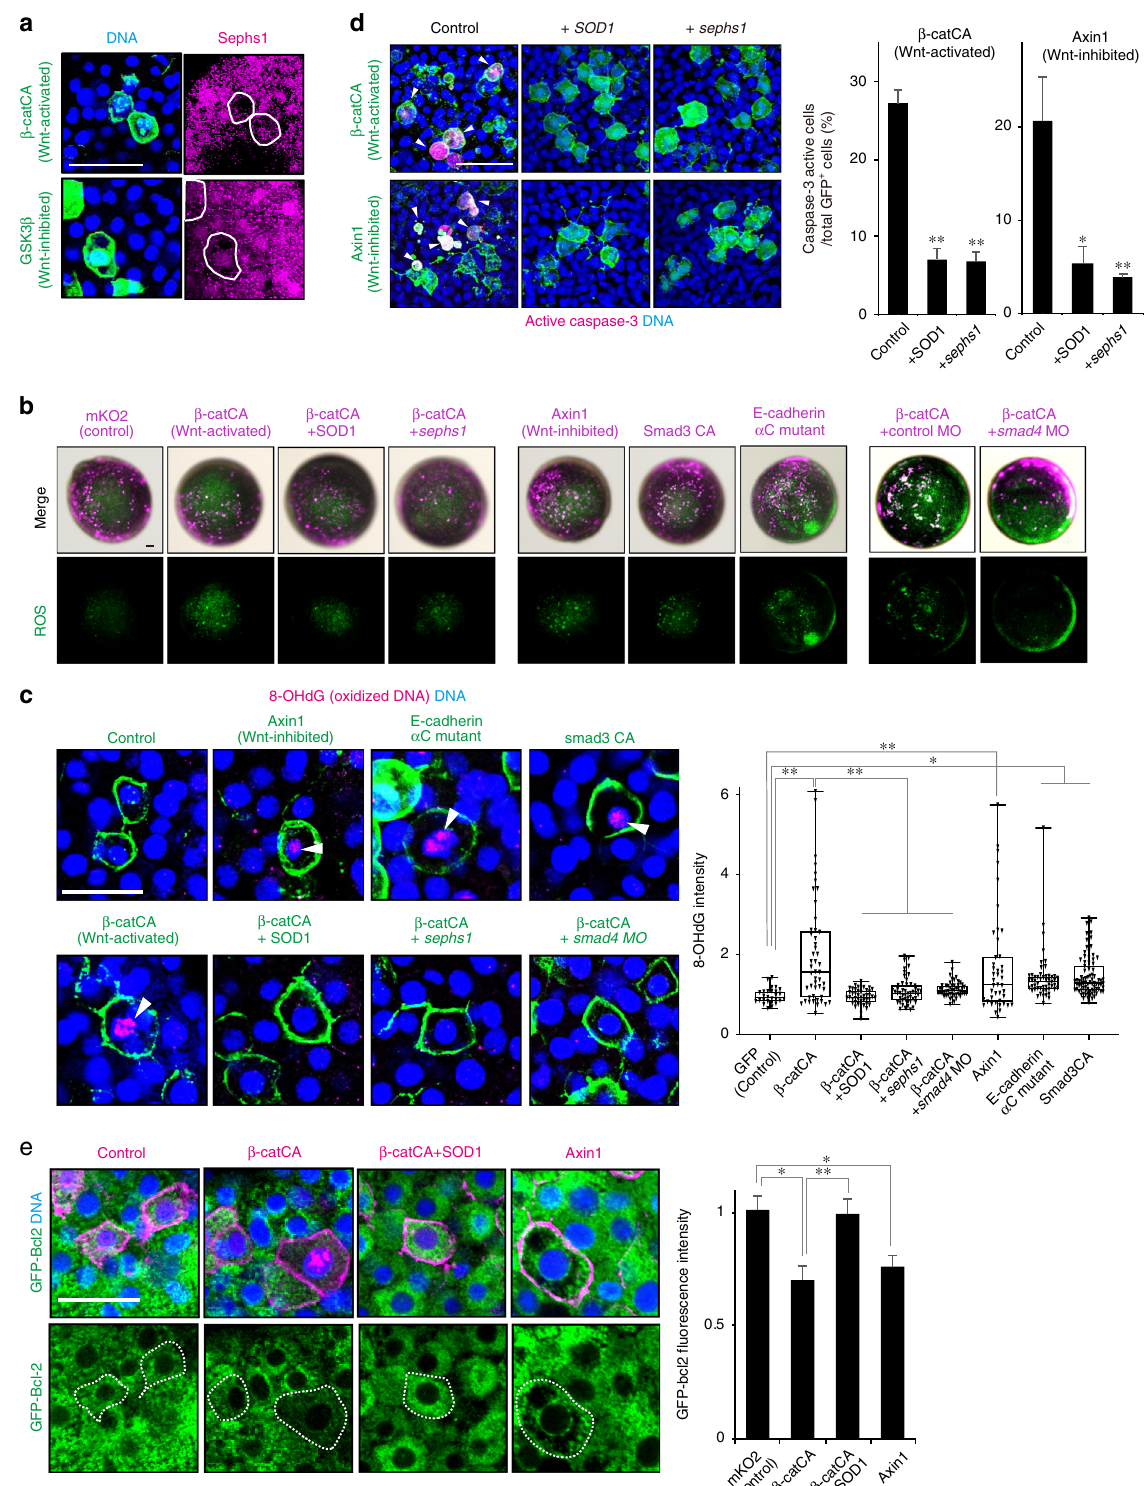
Plasmids . To prepare the luciferase-based reporter plasmid (OTM:ELuc-CP) (Supplementary Fig. 1a), d2EGFP of the OTM:d2EGFP plasmid was replaced with ELuc-PEST (Toyobo, Osaka, Japan) 13 . To enhance destabilization ef fi ciency, the CL1 sequence from pGL4.28 (Promega, Madison, WI) was inserted between ELuc cDNA and the PEST sequence. To prepare heat-shock promoter-driven plasmids, the hsp70l promoter was sub-cloned into the pTol2 vector (a gift from Dr. K. Kawakami). Subsequently, membrane-tagged (GAP43-fused) GFP (or mKO2) and T2A were sub-cloned into pTol2-hsp70l promoter plasmids. These plasmids